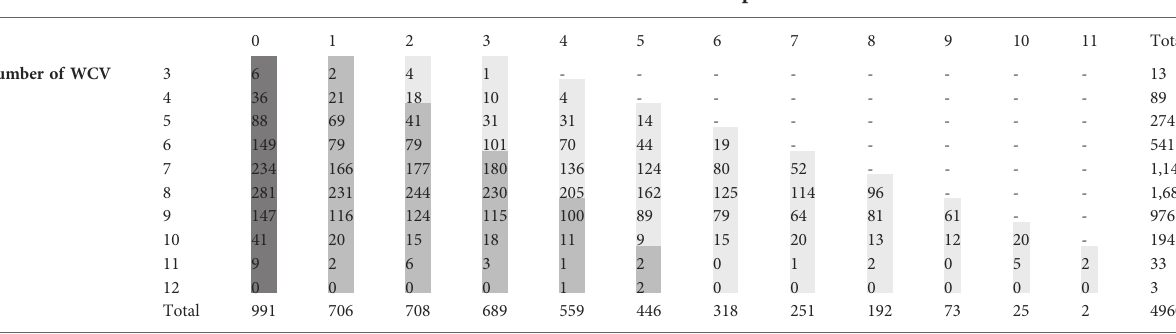
TABLE 1 The distribution of number of completed EHL questionnaires by number of WCVs attended per completer